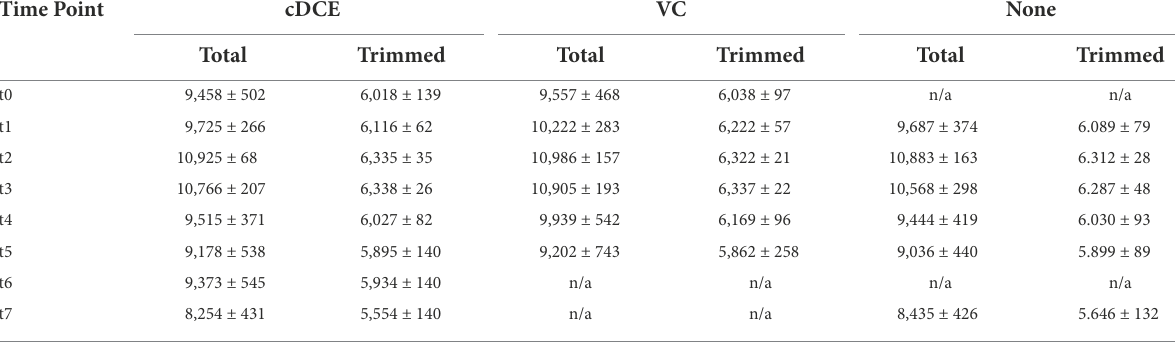
TABLE 2 Average number of detected features from each sample and time point before and after %CV data processing. Time